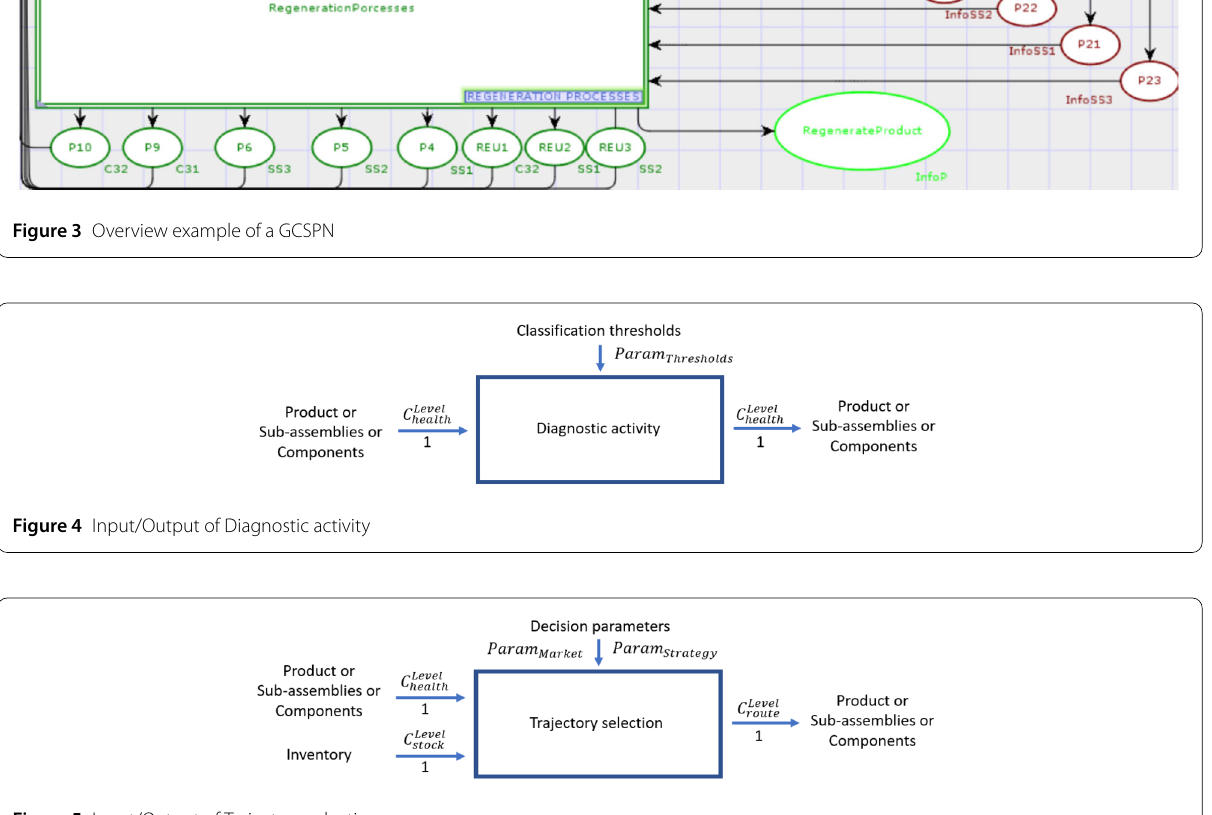
Figure 5 Input/Output of Trajectory